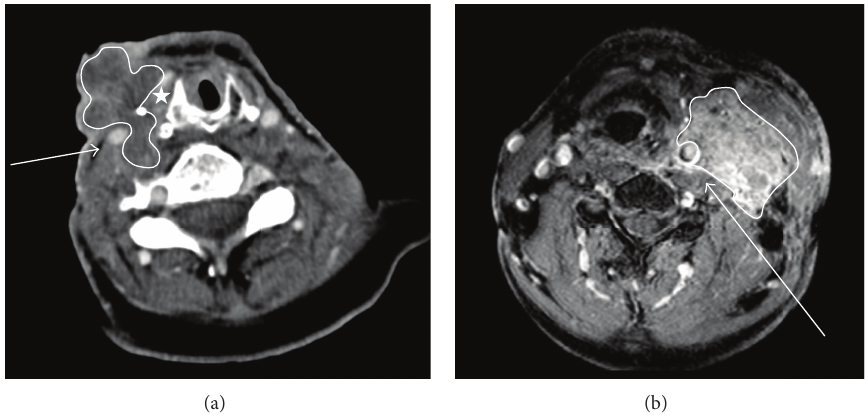
Figure 3: Examples of CT and MR images showing carotid encasement. (a) Axial CT image of a lymph node metastases (the mass is encircled by a white line) at the right side showing at least 270 degrees of encasement. The confluent lymph node mass is invading into the skin. The right carotid artery (arrow) is covered by the lymph node mass. Note: the right internal jugular vein is not visible, possibly due to compression. Suggestive the high-density structure (white star) lateral to the right lamina of the cricoid is surgical clip from earlier operation. (b) Fat- suppressed T1 contrast-enhanced MR section showing lymph node metastases in the left neck. The left internal carotid artery (arrow) is covered anteriorly and laterally by nodal disease (the mass is encircled by a white line). The circumferential involvement is (just) over 180